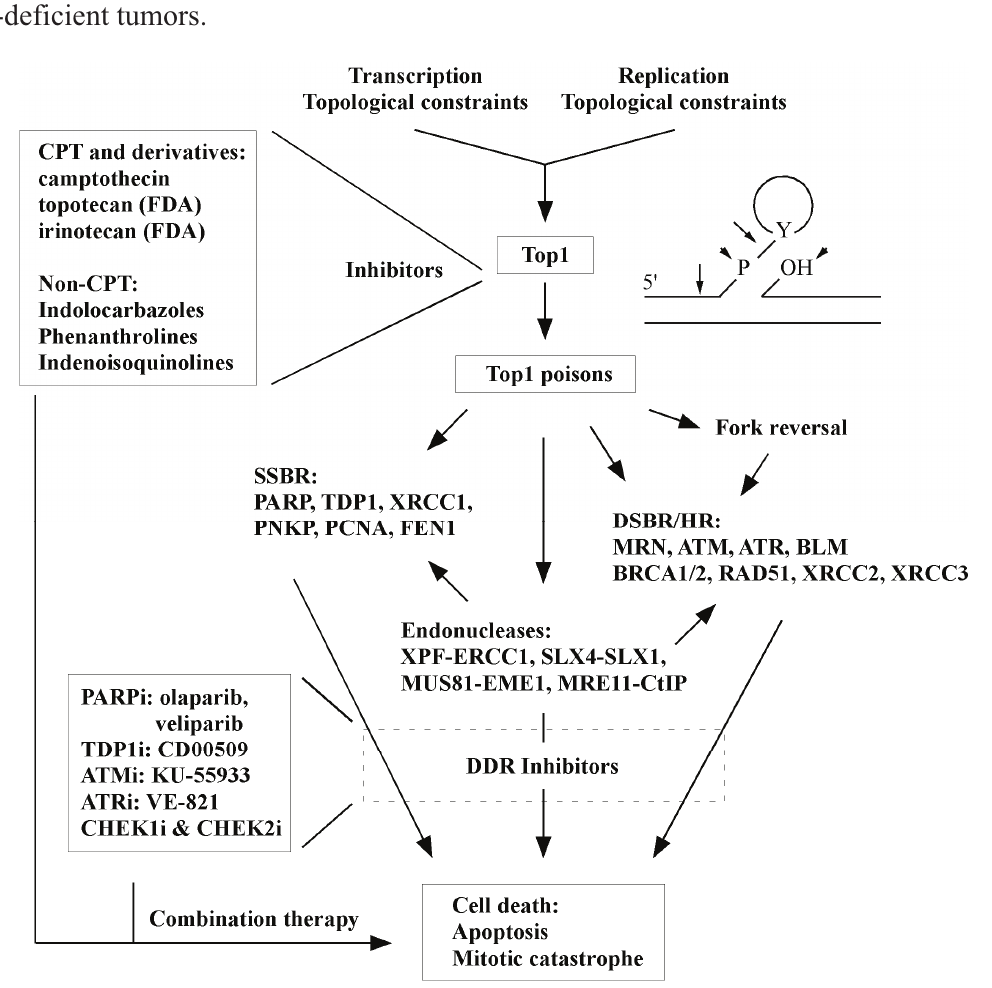
Figure 2. An overview of the effects of TOP1 inhibition is provided. Inhibitors and key DNA repair factors are